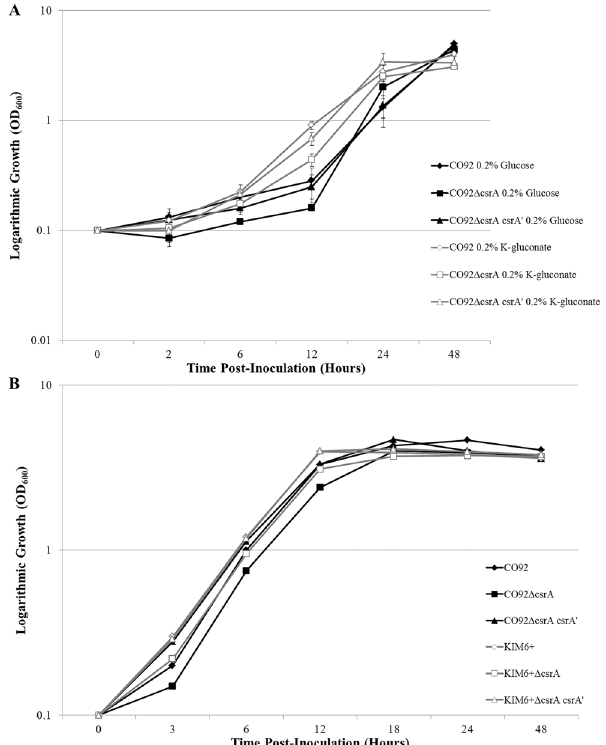
Fig 2. Y . pestis csrA -deficient Mutant 26°C Growth Kinetics. (A) Growth of CO92, CO92 Δ csrA , and the chromosomal restoration mutant CO92 Δ csrA csrA ’ in BCS medium supplemented with either 0.2% glucose or 0.2% K-gluconate during incubation at 26°C. (B) Growth kinetics of the CO92 and KIM6+ csrA -deficient mutants and respective controls when cultured in HIB medium at 26°C. No significant alteration in growth kinetics as determined by repeated measures ANOVA was calculated among the csrA -deficient mutants and the respective controls, regardless of media type or available carbon